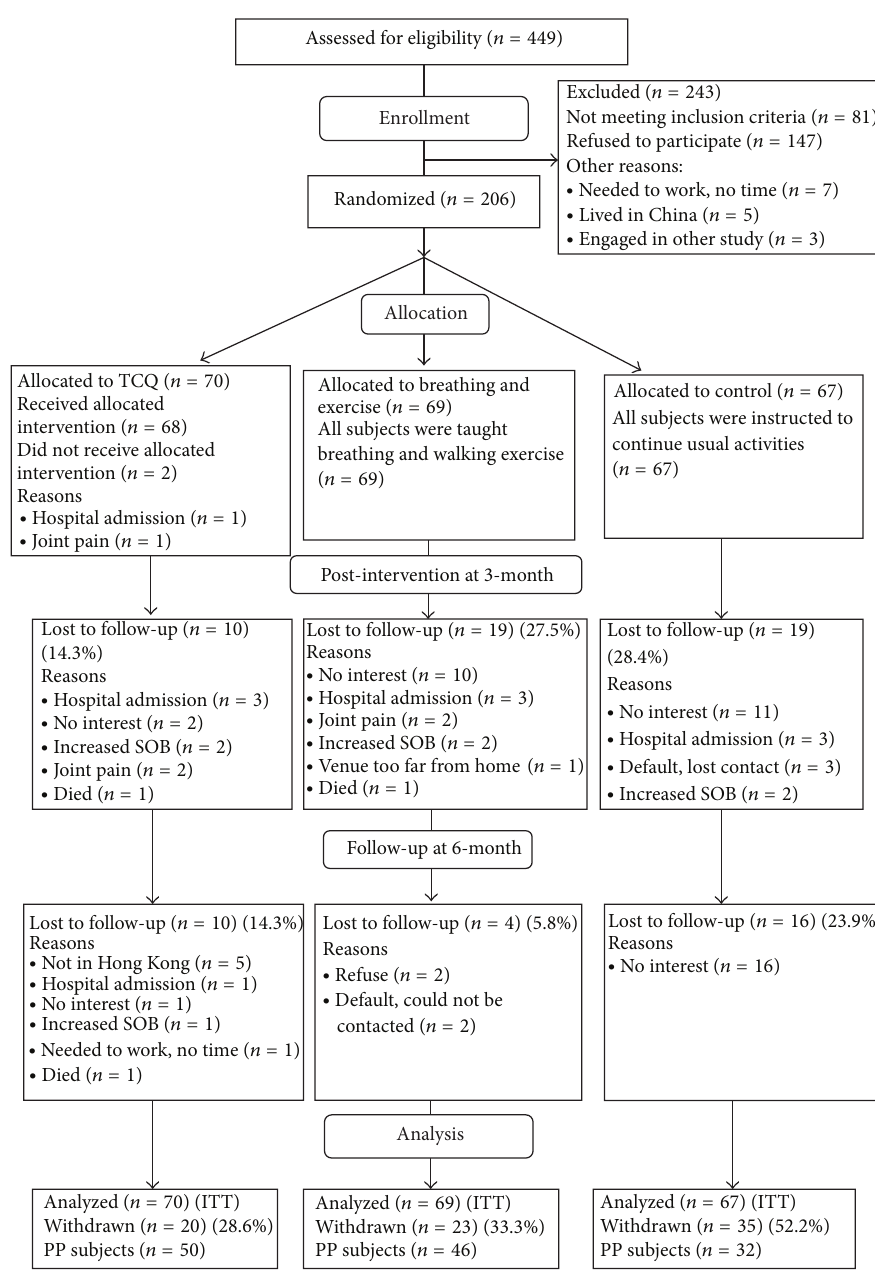
Figure 1: CONSORT (2005) flowchart to track participants through randomized controlled trail. ITT: intention to-treat; PP: per protocol